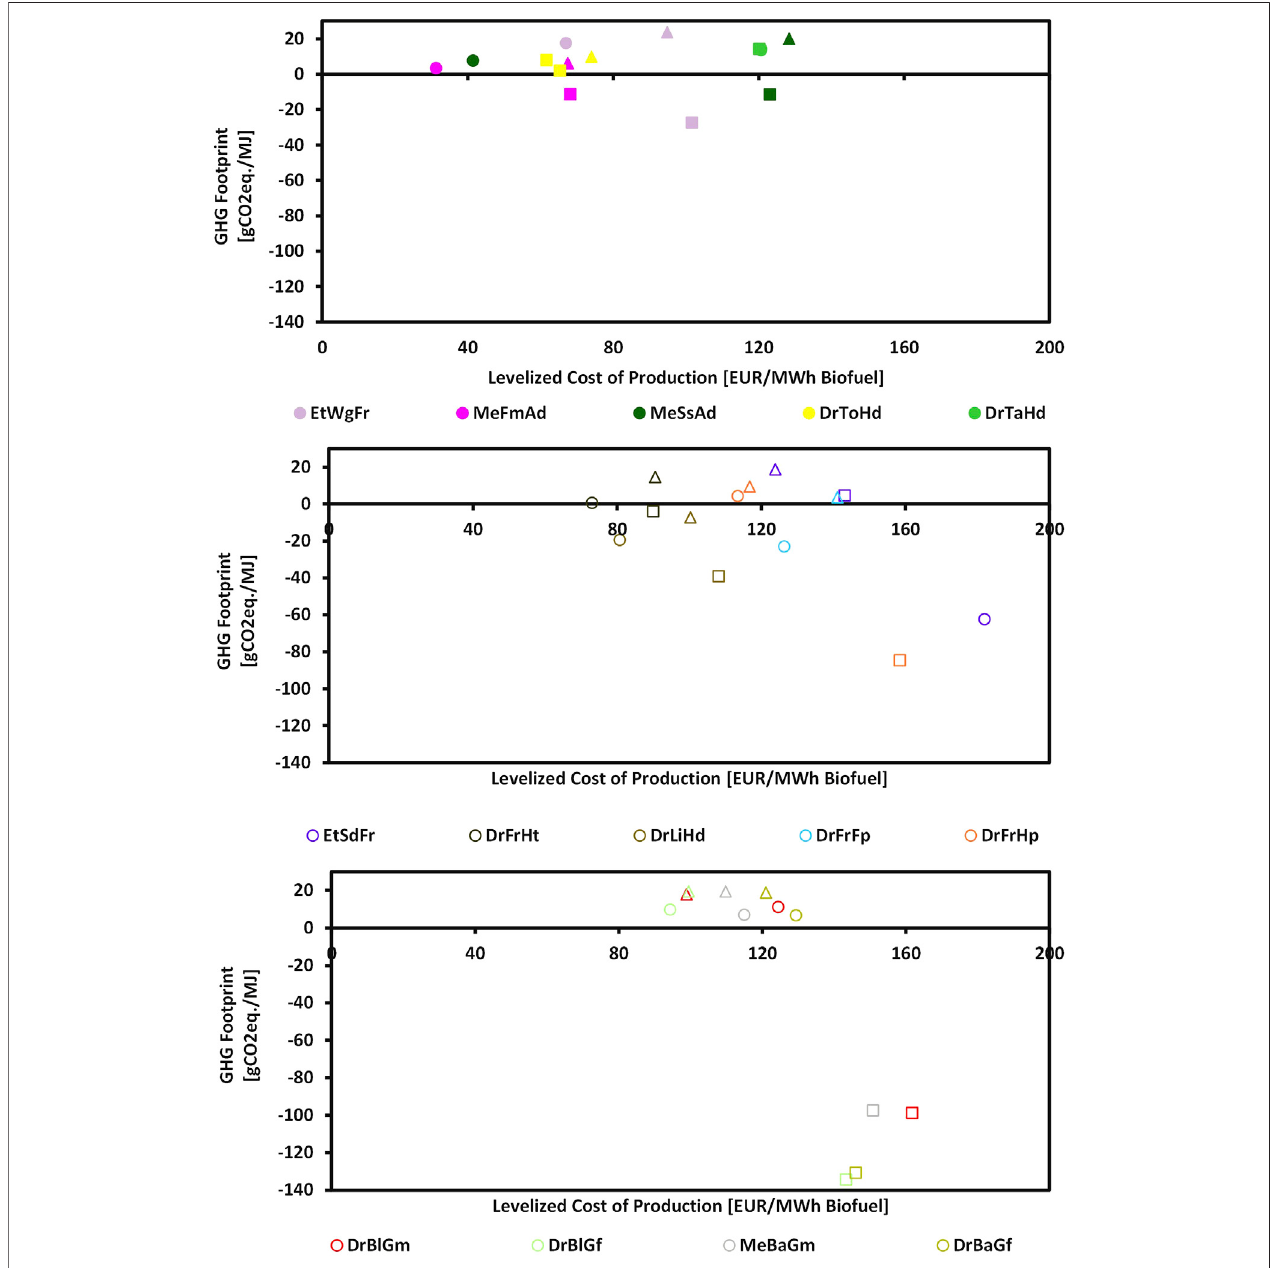
FIGURE 6 | GHG Footprints ( y -axis) and levelized costs of biofuel production ( x -axis) for the commercial biofuel pathways: EtWgFr, MeFmAd, MeSsAd, DrToHd and DrTaHd(top)andtheemergingbiofuelpathways: EtSdFr,DrFrHt,DrLiHd,DrFrFpandDrFrHp (middle), andDrBlGm,DrBlGf,MeBaGmand DrBaGf(bottom),under the base (circle), carbon capture and storage (CCS) (square), and carbon capture and utilization (CCU) (triangle) options. Empty markers represent emerging pathways and fi lled markers represent commercial pathways. See Table 1 for explanation of pathway abbreviations and the Supplementary Material for a tabular presentation of the